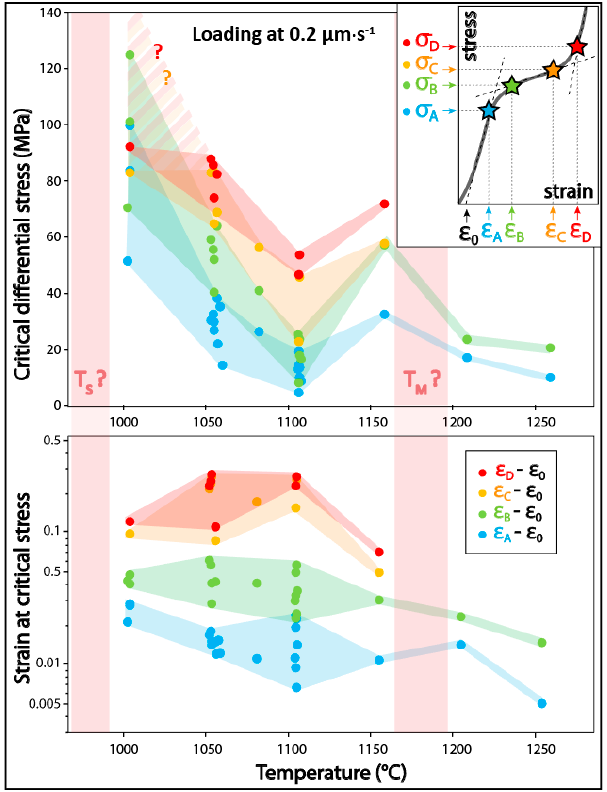
Figure 7. Slope of the stress–strain curve as a function of temperature. The observed enhanced plasticity is characterized by an average plastic response with d σ /d ε ≈ 0, which suggests TRIP. Considering the analogy with a martensitic-like transformation (see Section 5.1), T S and T M would account for the starting temperature and martensitic temperature, respectively, which would define the “martensitic window”, i.e., domain where the enhanced plasticity is observed. Temperature variation during loading is <6 ◦ C.